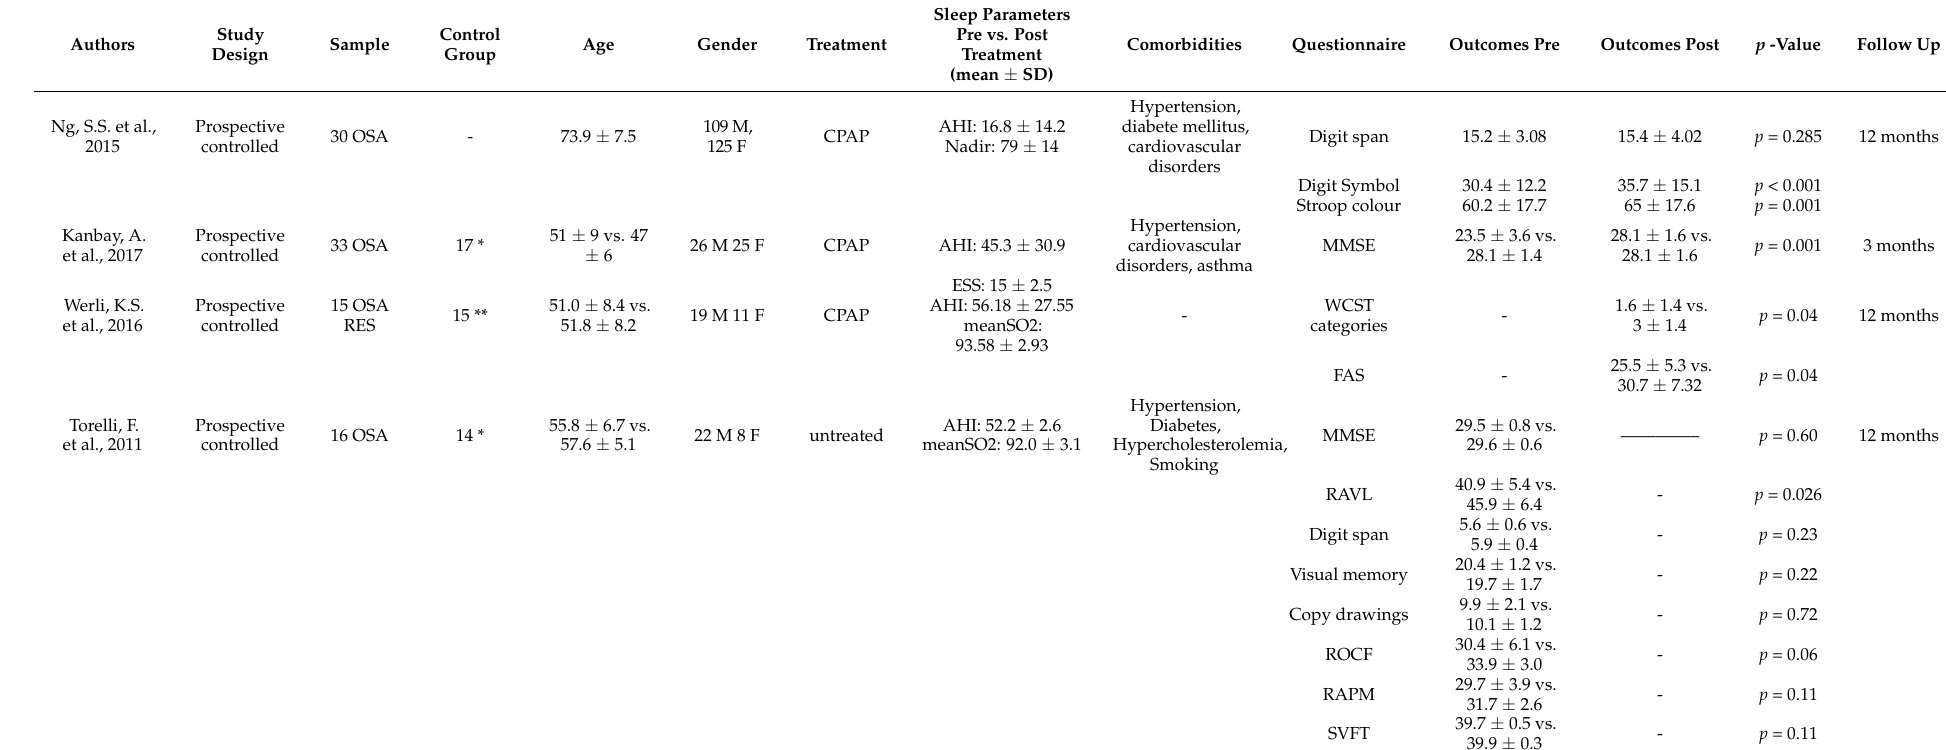
Table 1. Literature data retrieved by systematic review. Abbreviations: AHI, apnea/Hypopnea index; ESS, Epworth sleepiness scale; NadirSO2, lower oxygen saturation; MeanSO2, mean oxygen saturation; RDI, respiratory disturbance index; MMSE, mini-mental state examination; WCST Wisconsin Card Sorting Test; FAS, Verbal Fluency Test; RAVL, Rey Auditory-Verbal Learning; ROCF, Rey-Osterreith Complex Figure copy; RAPM, Raven’s Advanced Progressive Matrices; SVFT, Semantic verbal fluency task; PVFT, Phonological verbal fluency task; WAIS-R, Wechsler Adult Intelligence Scale-Revised; WCST, Wisconsin Card Sorting Test; EXIT, Executive interview; PHQ-9, Patient Health Questionnaire; TMB Trail-Making Test B; MoCA Montreal cognitive assessment; PFN-TOLT, Pathfinder Number Test-Total Time; BSRT-SR, Buschke Selective Reminding Test-Sum Recall; SWMT-OMD, Sustained Working Memory Test-Overall Mid-Day Index; ACE-R Addenbrooke’s Cognitive Examination-Revised; LM, Logical Memory; TMA Trail-Making Test A; CRD, Complex Reactiometer Drenovac test battery 311 (speed of perception to visual stimulus), 411 (speed of complex psycho-motor limbs coordination), 11 (speed of solving simple arithmetic operations), * healthy group, ** OSA